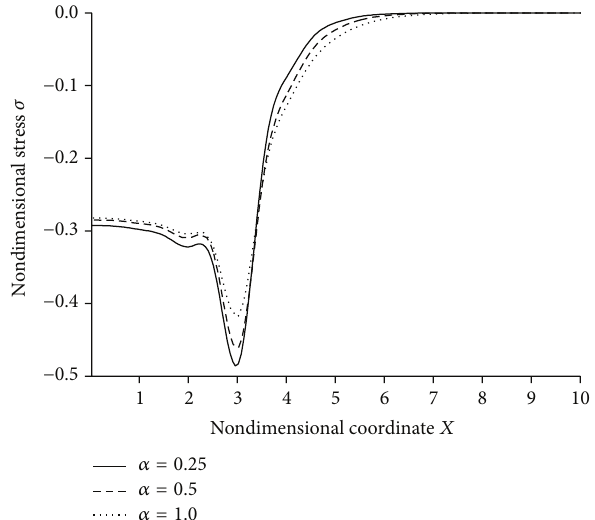
Figure14:Nondimensionalstressdistributionfordifferent 𝛼 values.